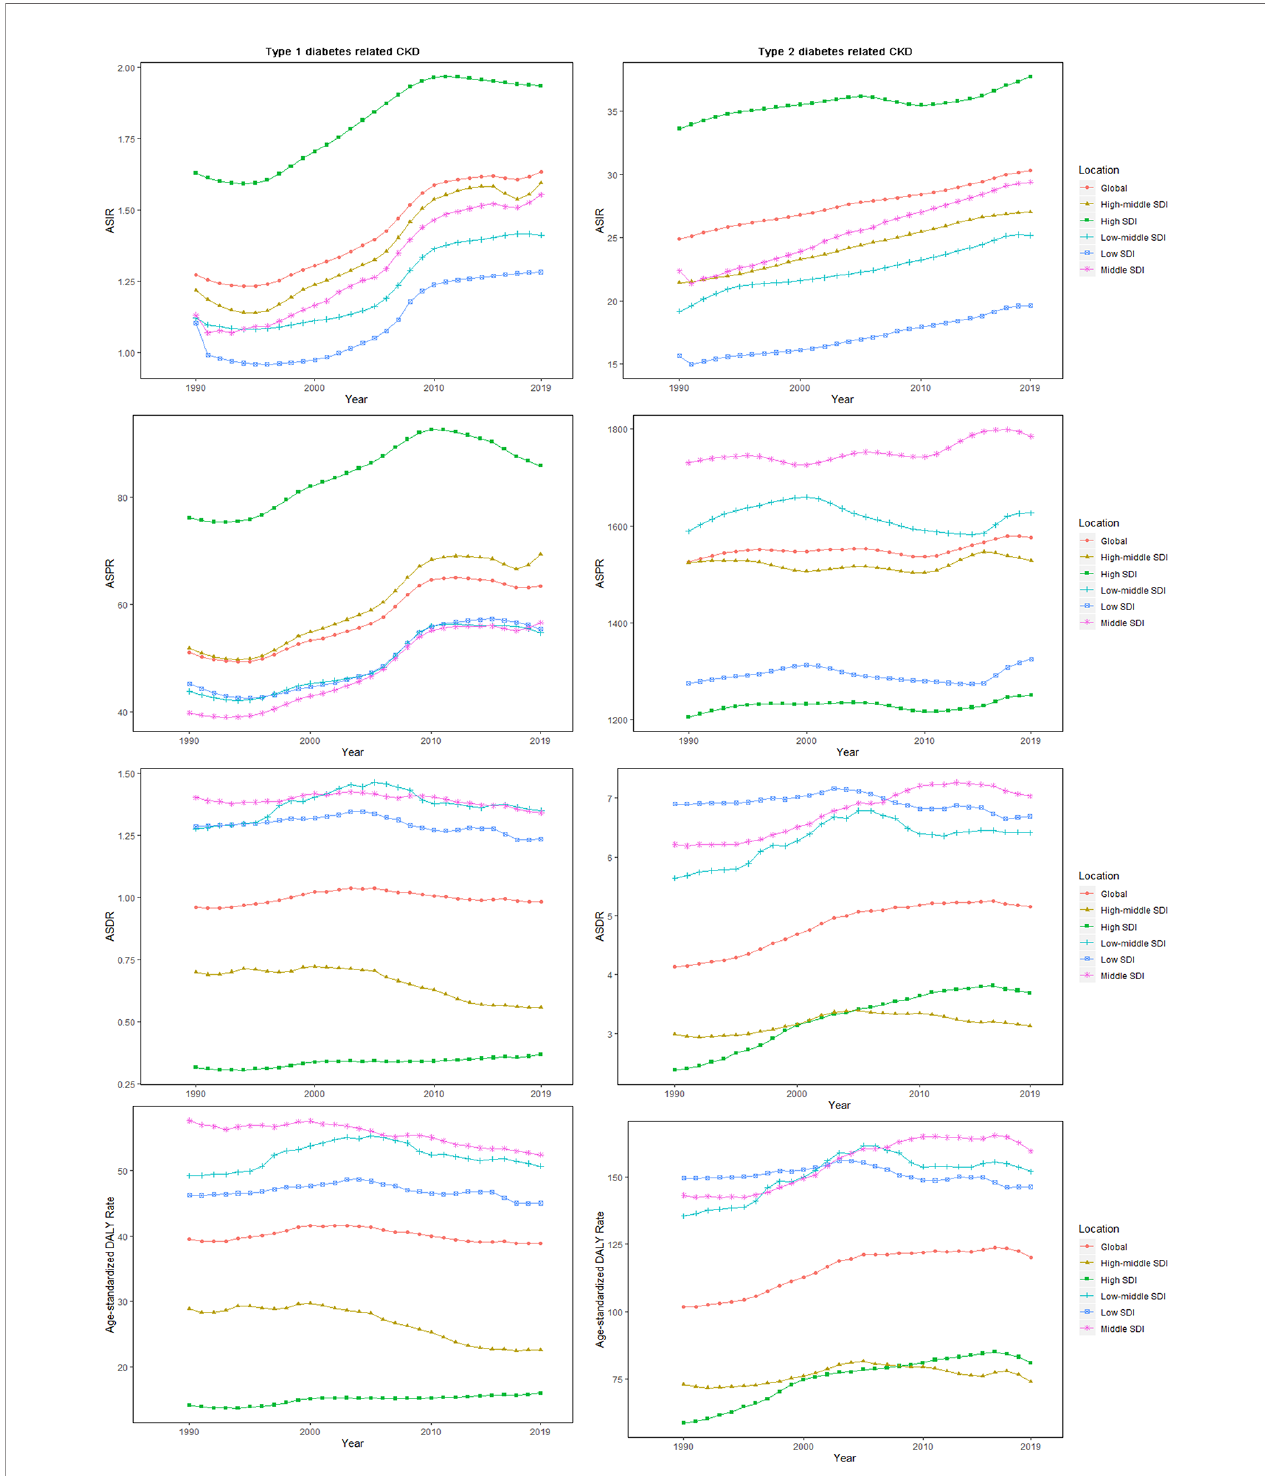
FIGURE 3 | The age-standardized rates for CKD-DM among SDI quintiles over 30 years. The vertical axis is the age-standardized incidence, prevalence, death, and DALY rate (per 100,000 person-years), and the horizontal axis is the 30 years (1990 – 2019). Each point represents the age-standardized incidence, prevalence, death, and DALY rate (per 100,000 person-years) that year. Each color and shape represents an SDI quintile (Global, High SDI, High-middle SDI, Middle SDI, Low- middle SDI, and Low SDI). CKD-DM, type 1 diabetes – related chronic kidney disease; DALY, disability adjusted life-year; ASIR, age-standardized incidence rate; ASPR, age-standardized prevalence rate; ASDR, age-standardized death rate; SDI, socio-demographic